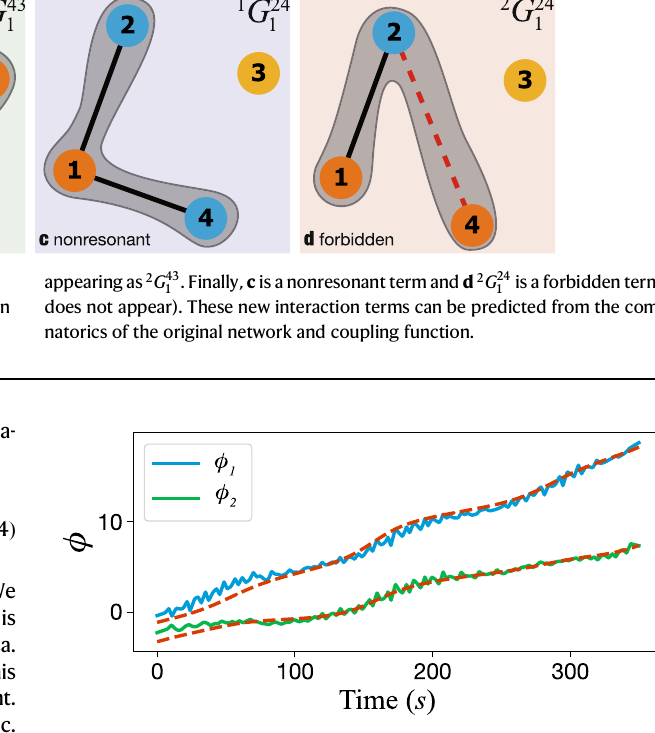
Fig.3|Normalformtheoryexplainstheexperimentalresults. Weshowthetime seriesoftheslowphase ϕ 1 and ϕ 2 fromexperimentaldata(solid)andtheprediction of the emergent hypernetwork (dashed) capturing higher-order interactions. The vector fi eld describing the phase interaction is obtained from fi rst principles. The coef fi cients of the vector fi eld are obtained by least-square